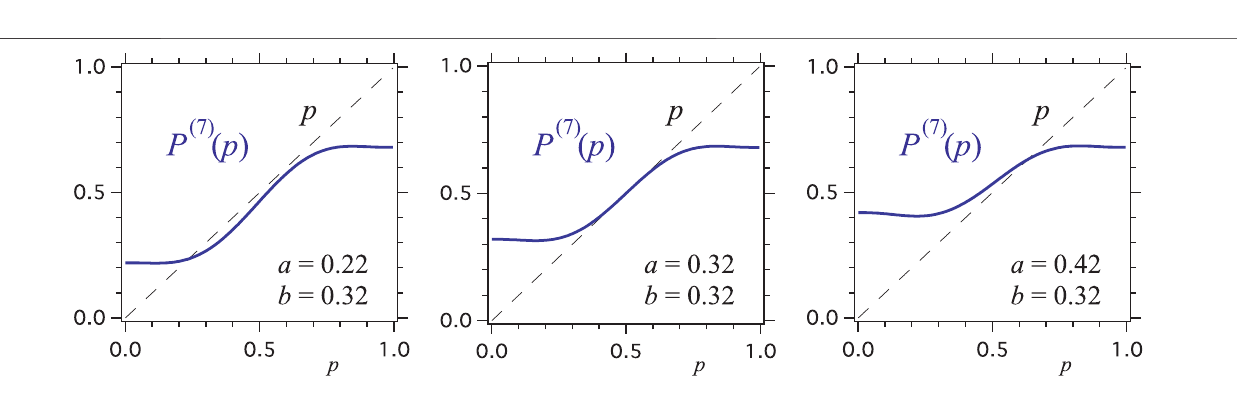
FIGURE 6 | Examples of the evolution function P r a , b , c , k ( p ) around triple critical value a (cid:2) b (cid:2) a t for c (cid:2) 0. The group size is chosen to be r (cid:2) 7.